Question: In a single sentence, describe what this figure presents.
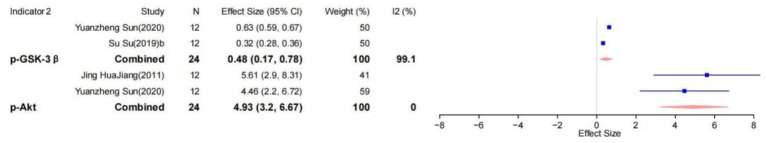
Answer: Inhibition of apoptosis forest plot.